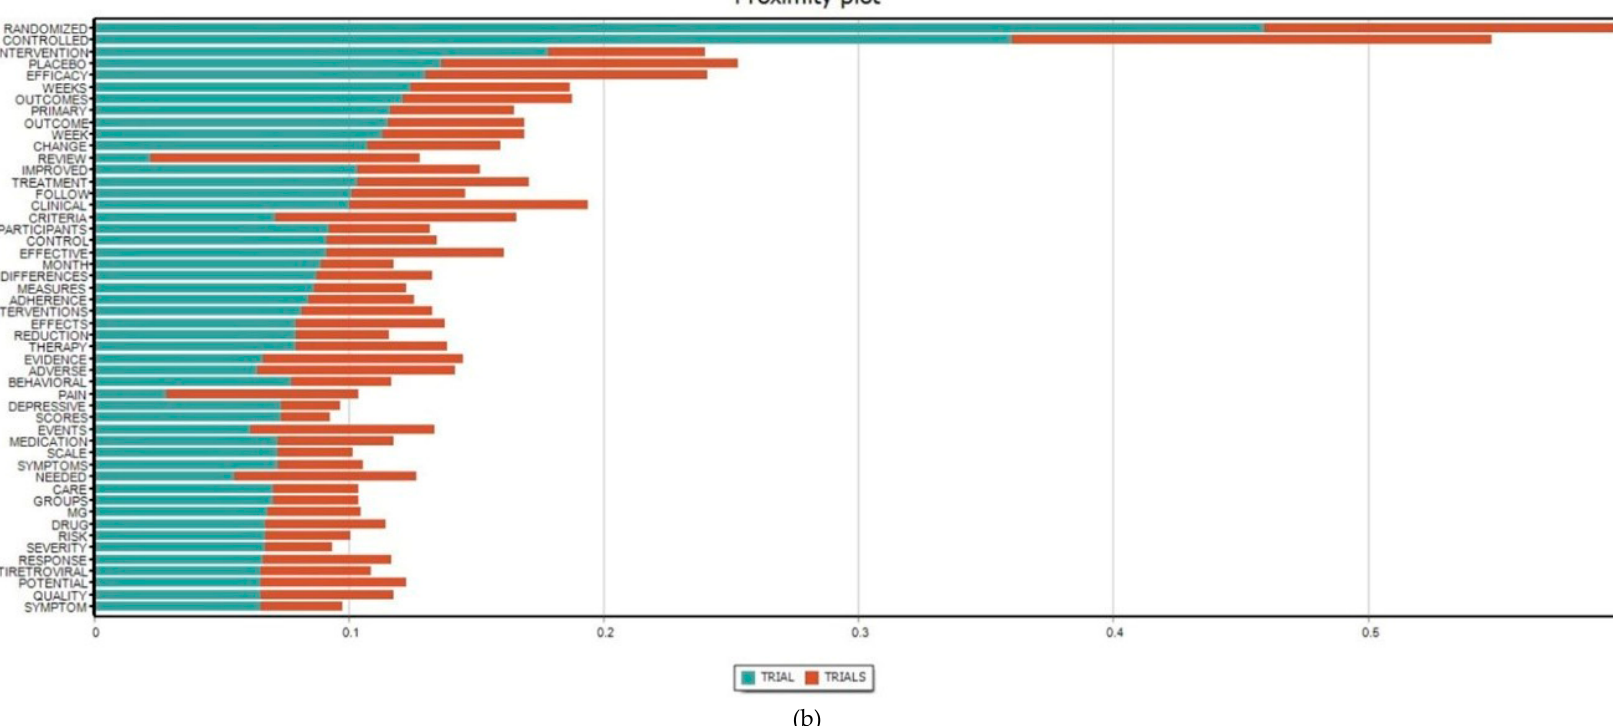
Figure 4. Proximity plots of the terms ( a ) “Intervention(s)” and ( b ) “Trial(s)” with the top 50 most frequent concurrence terms in all abstracts. The x-axis refers to the Jaccard coefficient that measures the similarity between finite sample sets and is defined as the size of the intersection divided by the size of the union of the sample sets.